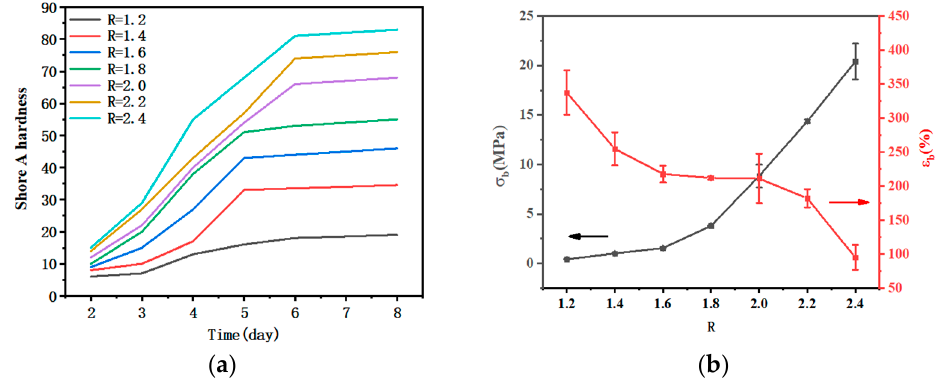
Figure 4. ( a ) Shore A hardness of the polymer fi lms with di ff erent R; ( b ) curves of tensile strength and elongation at break of polymer fi lms with di ff erent